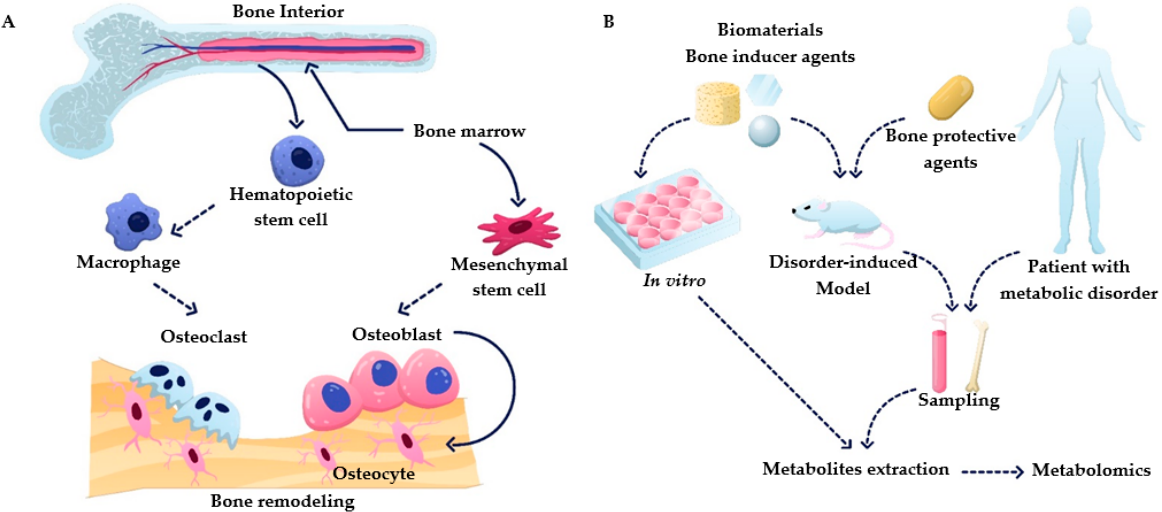
Figure 1. ( A ) Overview of bone remodeling processes, including osteogenesis and osteoclastogenesis. ( B ) Summary of metabolomics applications in bone research.